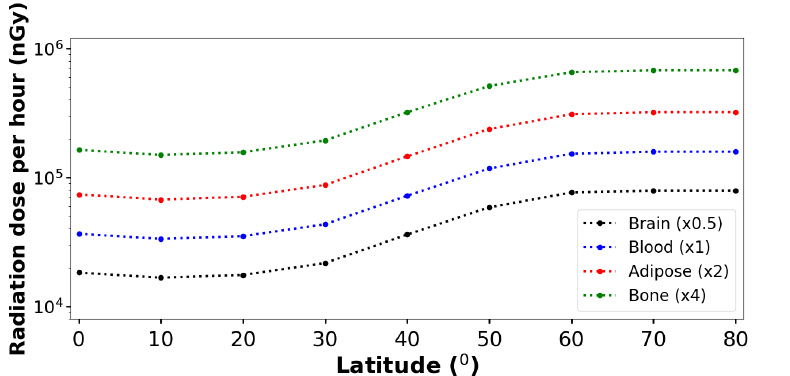
Figure 5. Radiation dose deposited in blood, adipose, brain and bone tissue samples by atmospheric neutrons with energies between 1 and 1000 MeV, as a function of the latitude for a altitude of 10 km and a longitude of 0 ◦ . This result was obtained by a numerical simulation, the RD was calculated for a period of one hour in spherical samples with a radius of 5 cm. See text for more